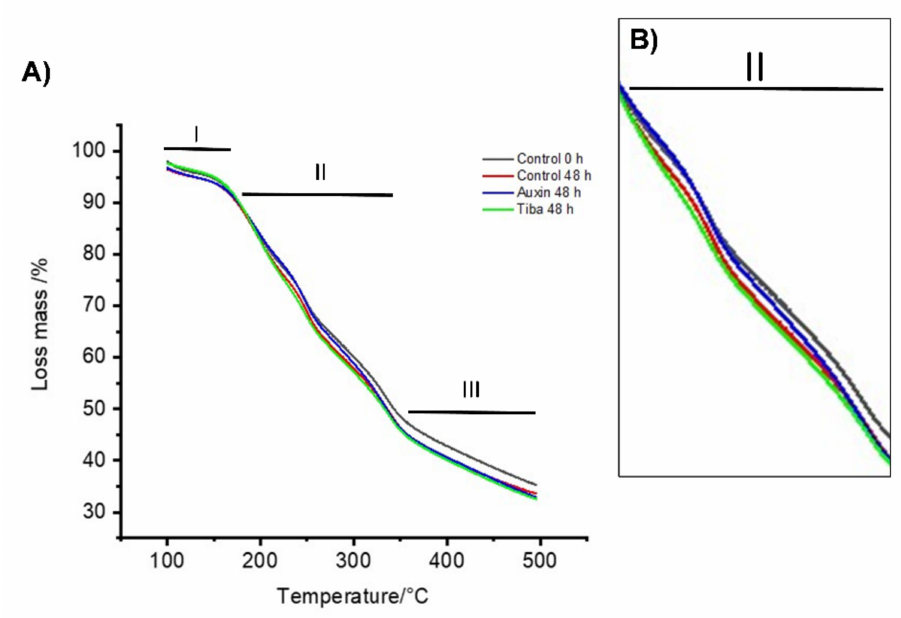
Figure 2. Thermogravimetric analysis (TGA). ( A ) Thermograms derived from each treatment at two different times with temperatures between 100 and 500 ◦ C. ( B ) Zoom in on region II of the thermogram where the main differences between treatments are